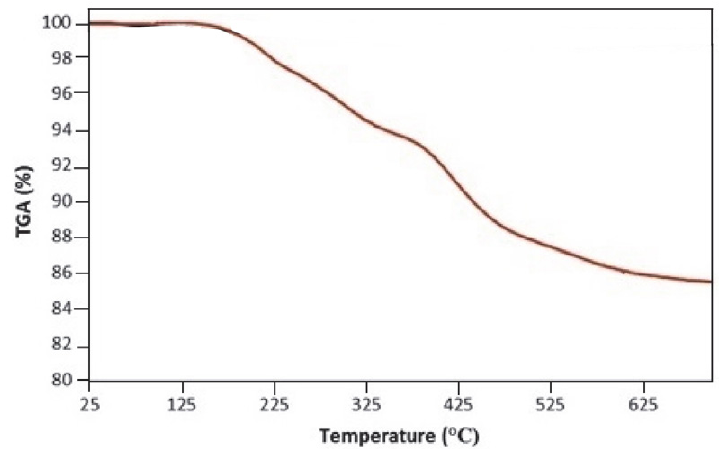
Figure 5. Thermograms of pure Fe 3 O 4 MNPs (black) and Fe 3 O 4 @ PyHBr 3 MNPs